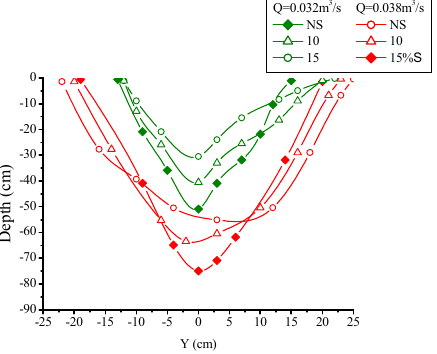
Figure 7. Lateral bed profile upstream from the